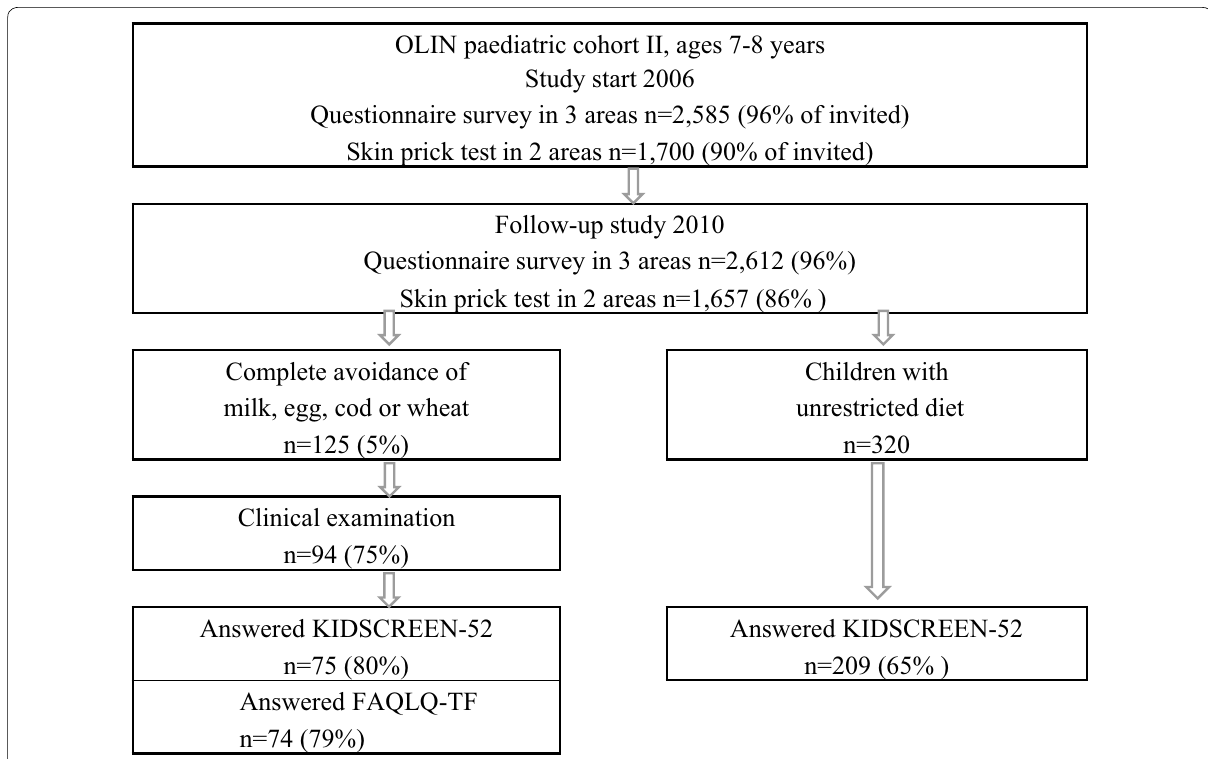
Fig. 1 Study design and